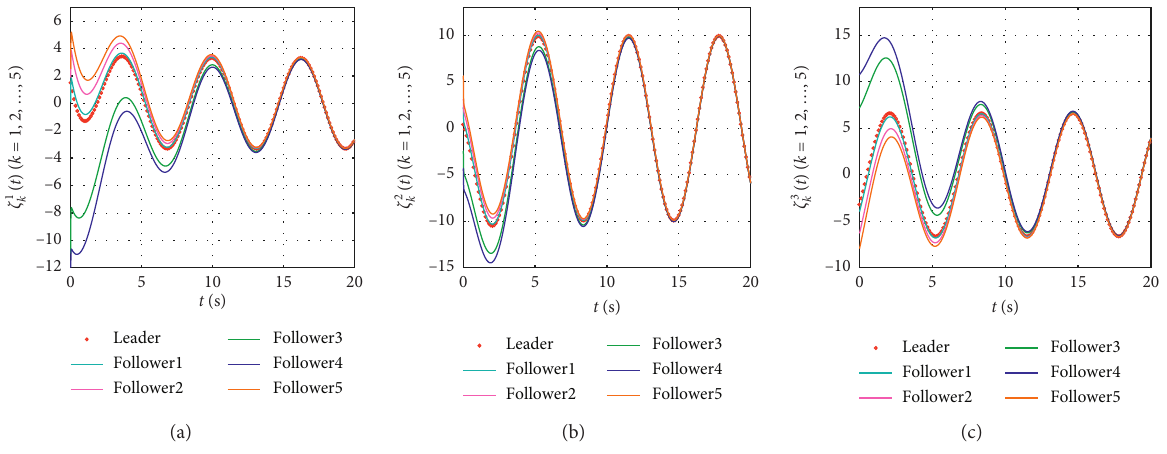
Figure 2: Trajectories of ς ( t ) , ( k � 1 , 2 , . .. , 5 ) for time-varying formation tracking case. k